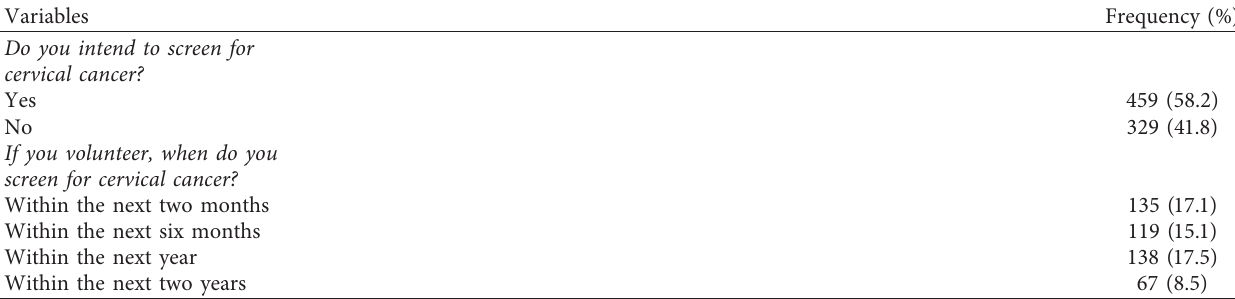
Table 2: Cervical cancer screening acceptance among women in Dabat district,